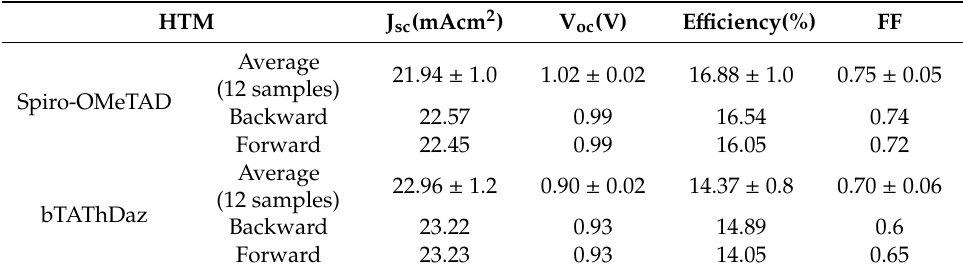
Table 2. Photovoltaic parameters of investigated perovskite solar cells with various HTM.